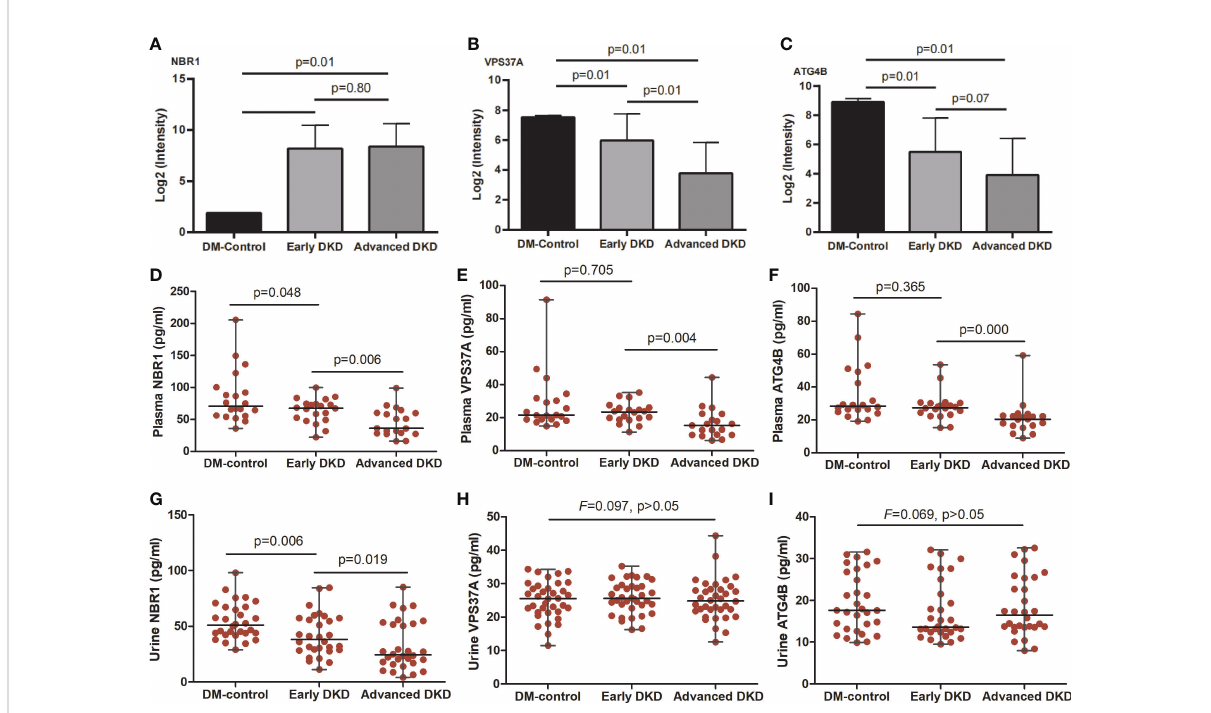
FIGURE 5 NBR1, VPS37A, and ATG4B expression in renal tissue, blood, and urine. (A-C) show the NBR1, VPS37A, and ATG4B expression, respectively, in renal tissue; the p-values were calculated by one-way ANOVA followed by LSD -test. (D-F) show serum levels and (G-I) show urine levels of NBR1, VPS37A, and ATG4B, respectively; the p-values were calculated by one-way ANOVA followed by Mann-Whitney U -test. ANOVA, analysis of